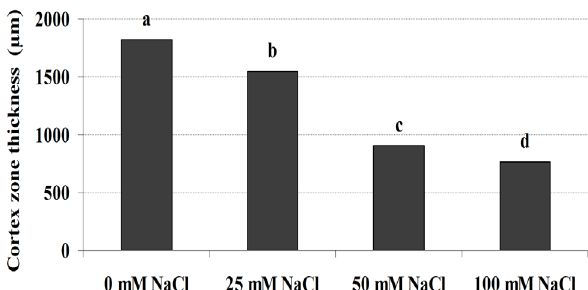
Fig. 3. Changes in stem cortex zone thickness affected by dif- ferent salinity stress. Within each column followed by the same letter are not significantly differences (p < 0.05)